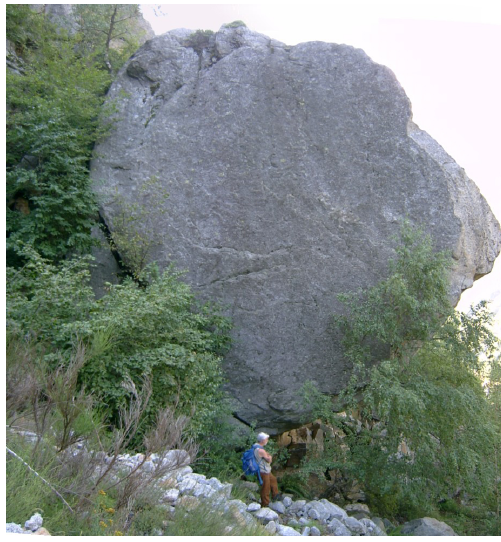
Figure 7. An example of the huge, disjointed stony blocks outcrop- ping on the left slope of the Orco Valley, behind a settled area a few hundred metres downslope (photo 21 July 2004).